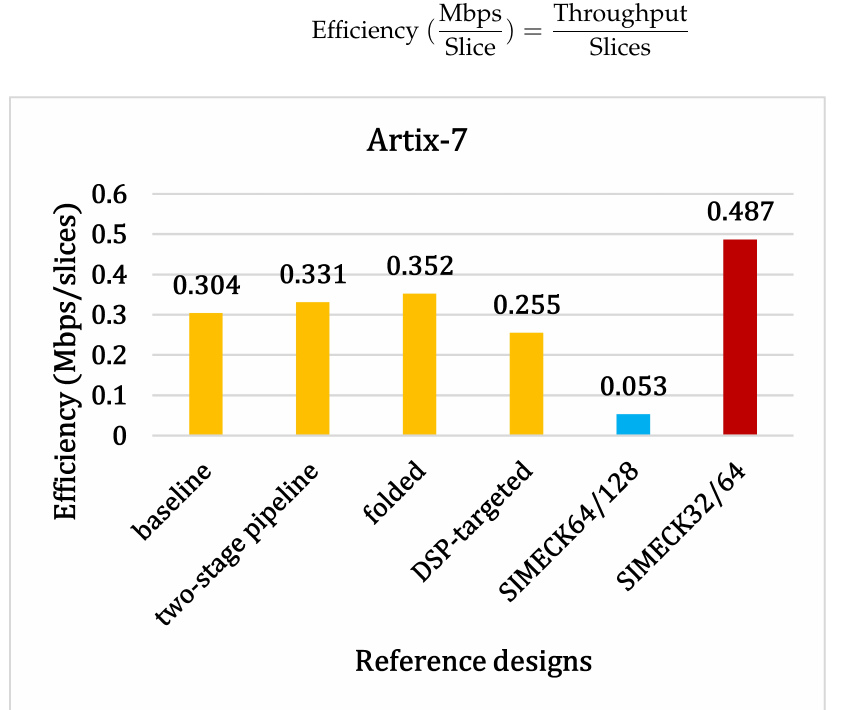
Figure 4. Efficiency evaluation with various optimization techniques of [20] and a design of [31] on Artix-7. The design of [20] is for SIMECK32/64 block cipher. The orange color bars are for [20] and a blue color bar is for [31]. The red color bar represents our work.